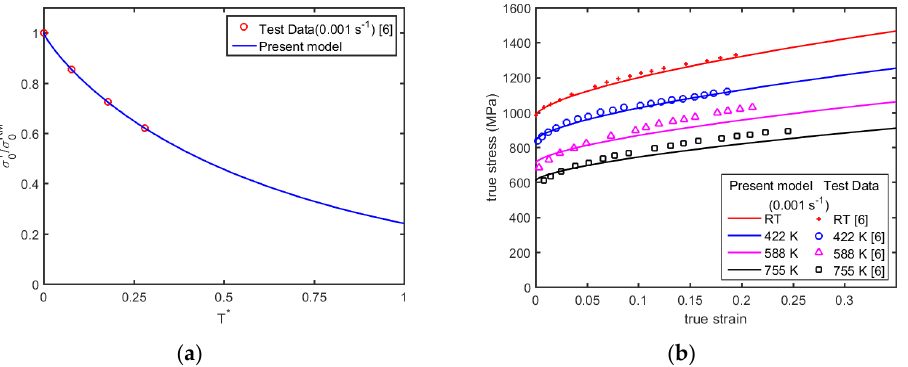
Figure 12. Comparison of the present model predictions with the compression test data for Ti-6Al-4V. ( a ) σ 0 T / σ 0 Ta versus T * at a plastic strain of 0.05 under strain rate of 0.001 s − 1 ; and ( b ) true stress-true strain curves at elevated temperatures.